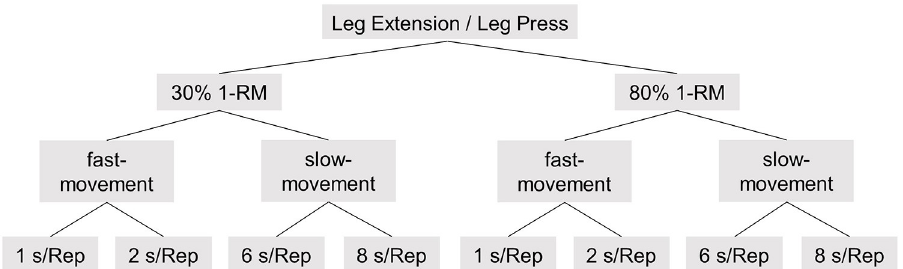
Fig 1. Study design. Two different intensities (30% and 80% one repetition maximum) with fast- (1 s/repetition, 2 s/ repetition) and slow-movement repetition (6 s/repetition, 8 s/repetition) velocities on single-joint (leg extension) and multi-joint (leg press) machines were